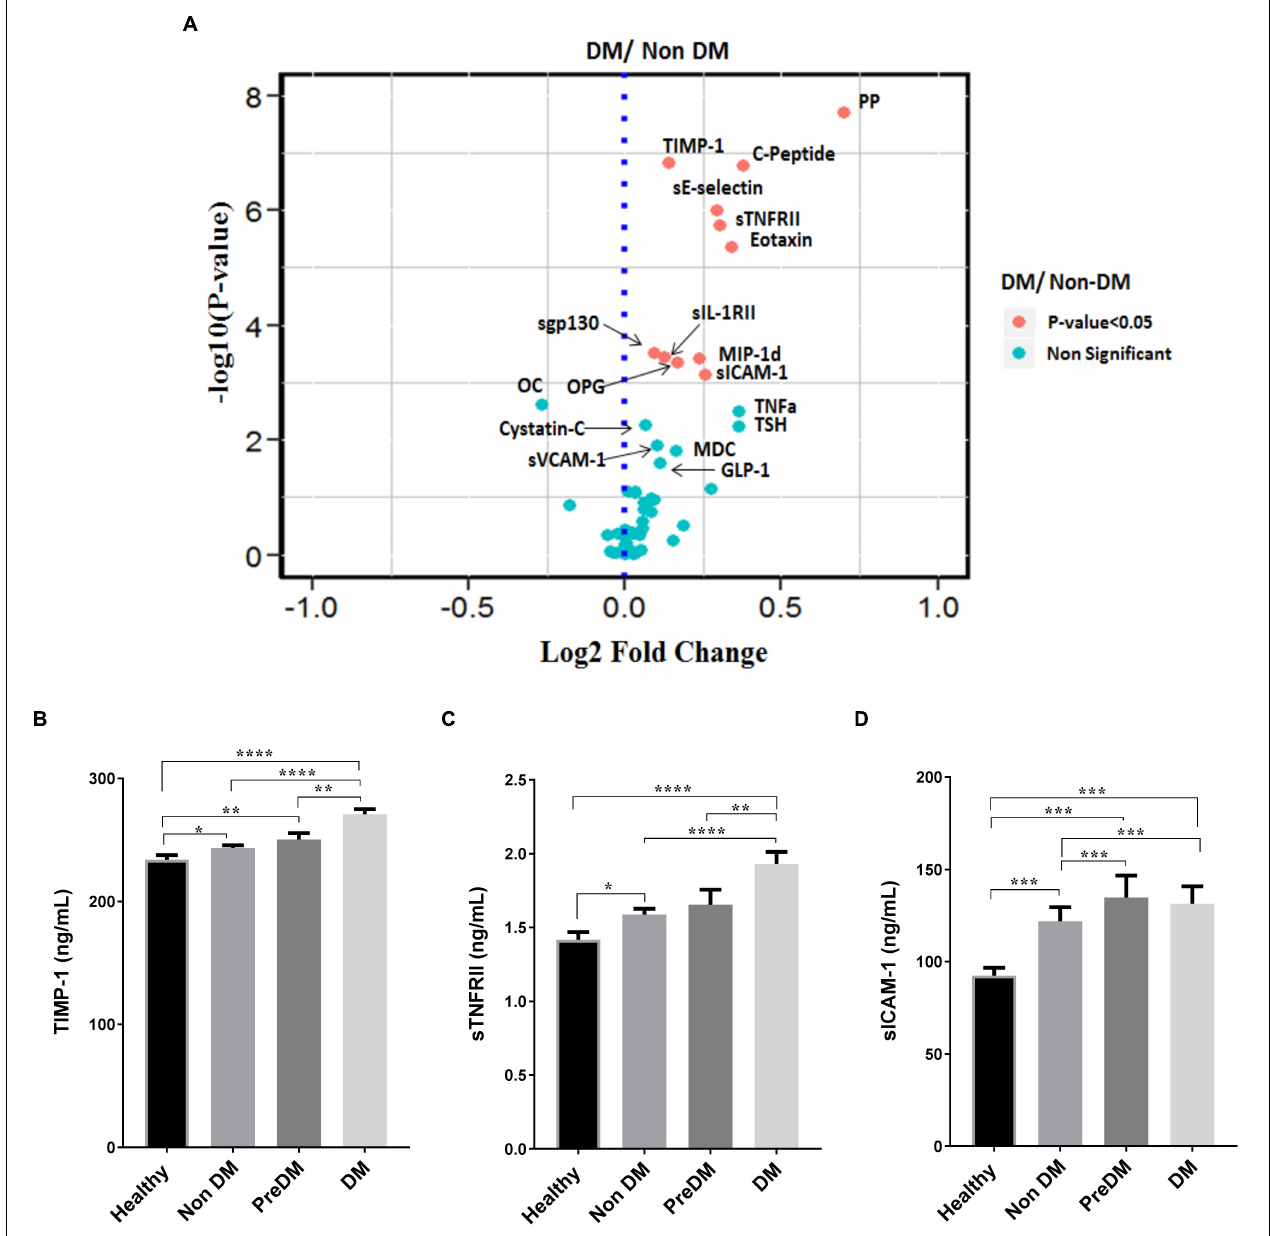
FIGURE 3 | Increased inflammatory molecules in Diabetes individuals. (A) A representative Volcano plot comparing all measured molecules between DM and Non-DM individuals, red labeled dots indicate a significant difference ( P < 0.05) between the two groups. Cytokine comparison between the four groups show significantly high ( P < 0.05) level in DM individuals for TIMP-1 (B) , sTNFRII (C) , and sICAM-1 (D) . The volcano plot was done by first taking the Fold change (which was calculated by dividing the average value of each molecule in DM and Non-DM individuals) and then using the log2 fold change against the –log10 P -value of each molecule. P -values were calculated using non-parametric Kruskal–Wallis test and Mann–Whitney U -test for comparing for more than two groups and for comparing between two groups, respectively, then adjusted for Bonferroni multiple test correction (ns P > 0.05, ∗ P < 0.05, ∗∗ P < 0.01, ∗∗∗ P < 0.001, ∗∗∗∗ P <